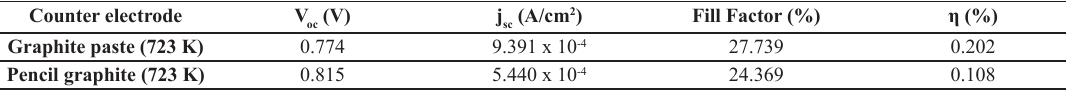
Table 3. j x V curve results of cells using pencil graphite and graphite paste as counter electrode. Counter electrode